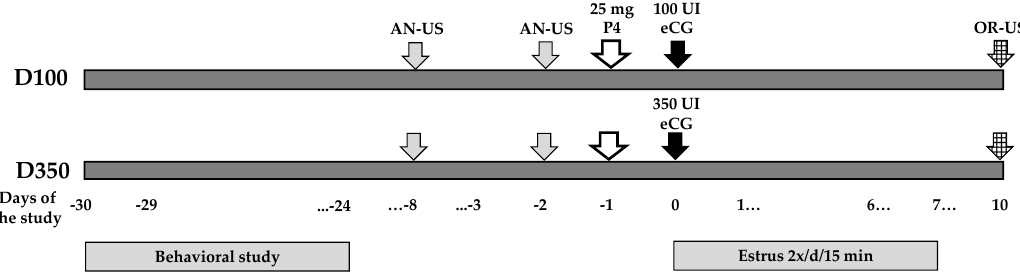
Figure 1. Schematic representation of the experimental protocol. In February, the behavioral study was carried out to define the social ranks; either high (HSR), middle (MSR), or low (LSR) social rank. Then, all goats were exposed to an estrus induction protocol, in order to induce reproductive activity during the natural anestrous season in Northern Mexico (March; 25° North). All goats were primed with progesterone (P4) and received different doses of eCG (100 or 350 IU). Estrus activity was evaluated daily after the application of the eCG doses up to day 7. Transrectal ultrasound (US) scanning were performed on days −8 and −2 to confirm anovulation (AN) as well as on days 10 post-eCG treatment, to assess both ovulatory rate (OR).